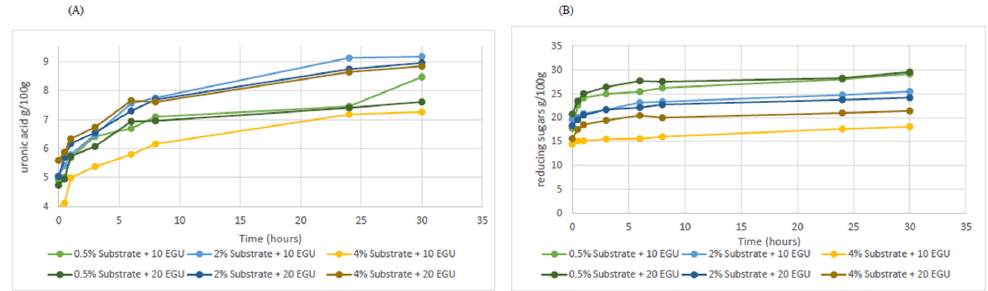
Figure 2. Determination of ( A ) uronic acids and ( B ) reducing sugars released from apple by-product during enzymatic treatment with Celluclast ® at atmospheric pressure. Data are expressed as g/100 g dry material.